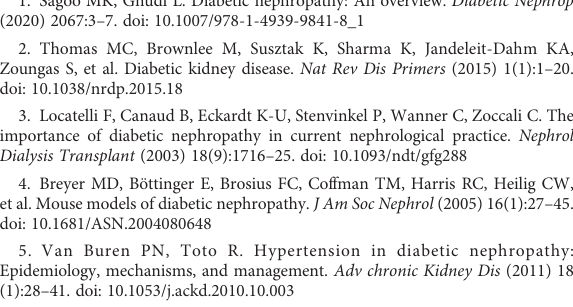
Weighted gene co-expression network analysis. (A) By WGCNA, 7 co- expression modules were obtained. (B) In order to make the gene expression regulatory network fi t a scale-free distribution, we fi nally chose a soft threshold of 14. (C) The correlation of the 7 co-expressed module genes with Stemness. (D) The correlation of the 7 co-expressed module genes with Immune Chaos. (E) Correlation of 7 co-expressed module genes with Pseudotime. Correlations are described using the pearson correlation coef fi